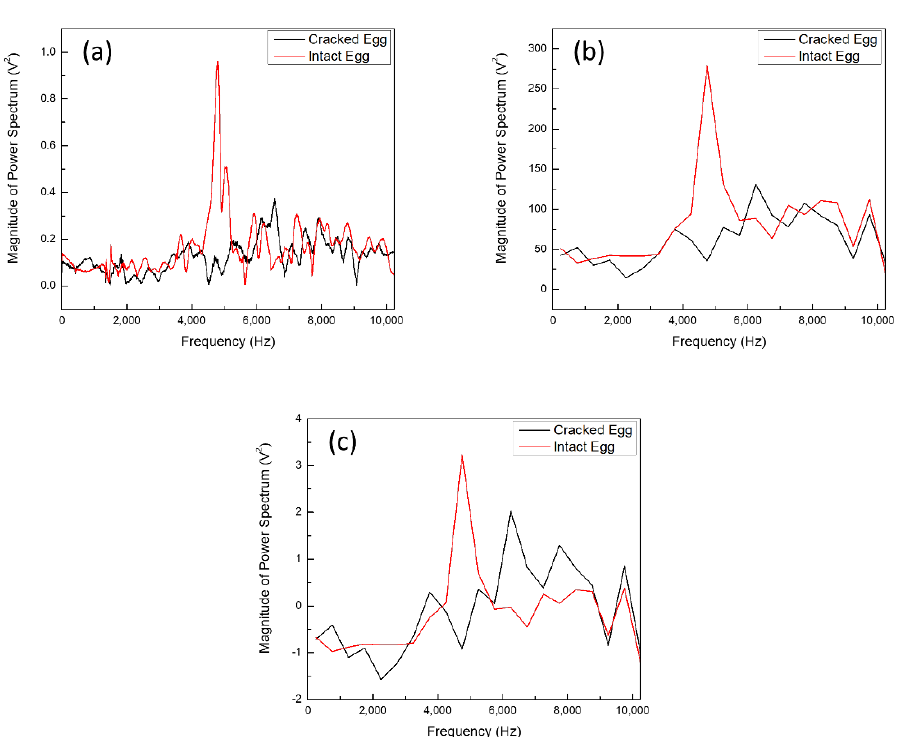
Figure 3. ( a )Typical ( b ) Integrate ( c ) Normalized frequency-domain spectra of intact eggs (red line) and cracked eggs (black line).